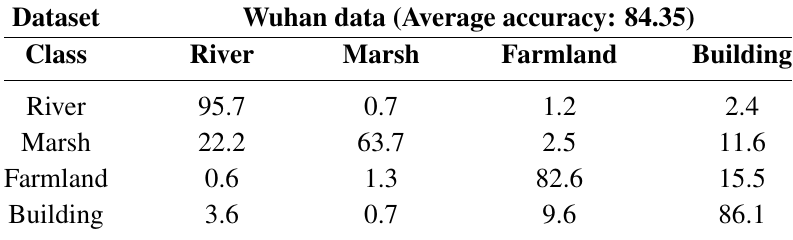
Table 6. Confusion matrix for the MAS + MRF result (percentage).